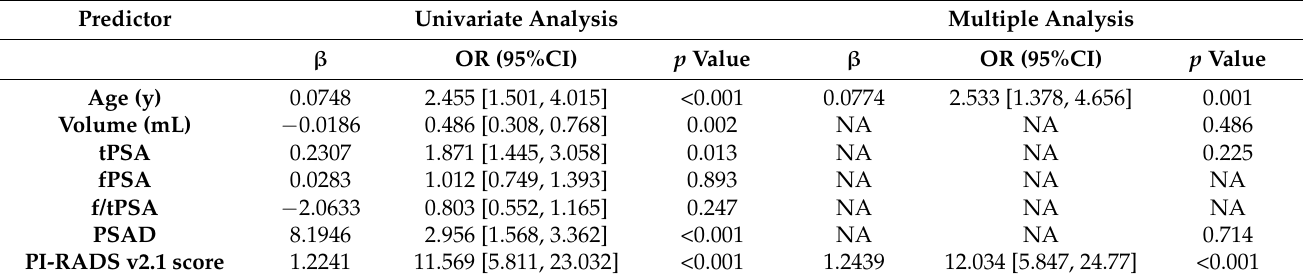
Table 2. Univariate and multiple logistic analysis results of clinical factors.